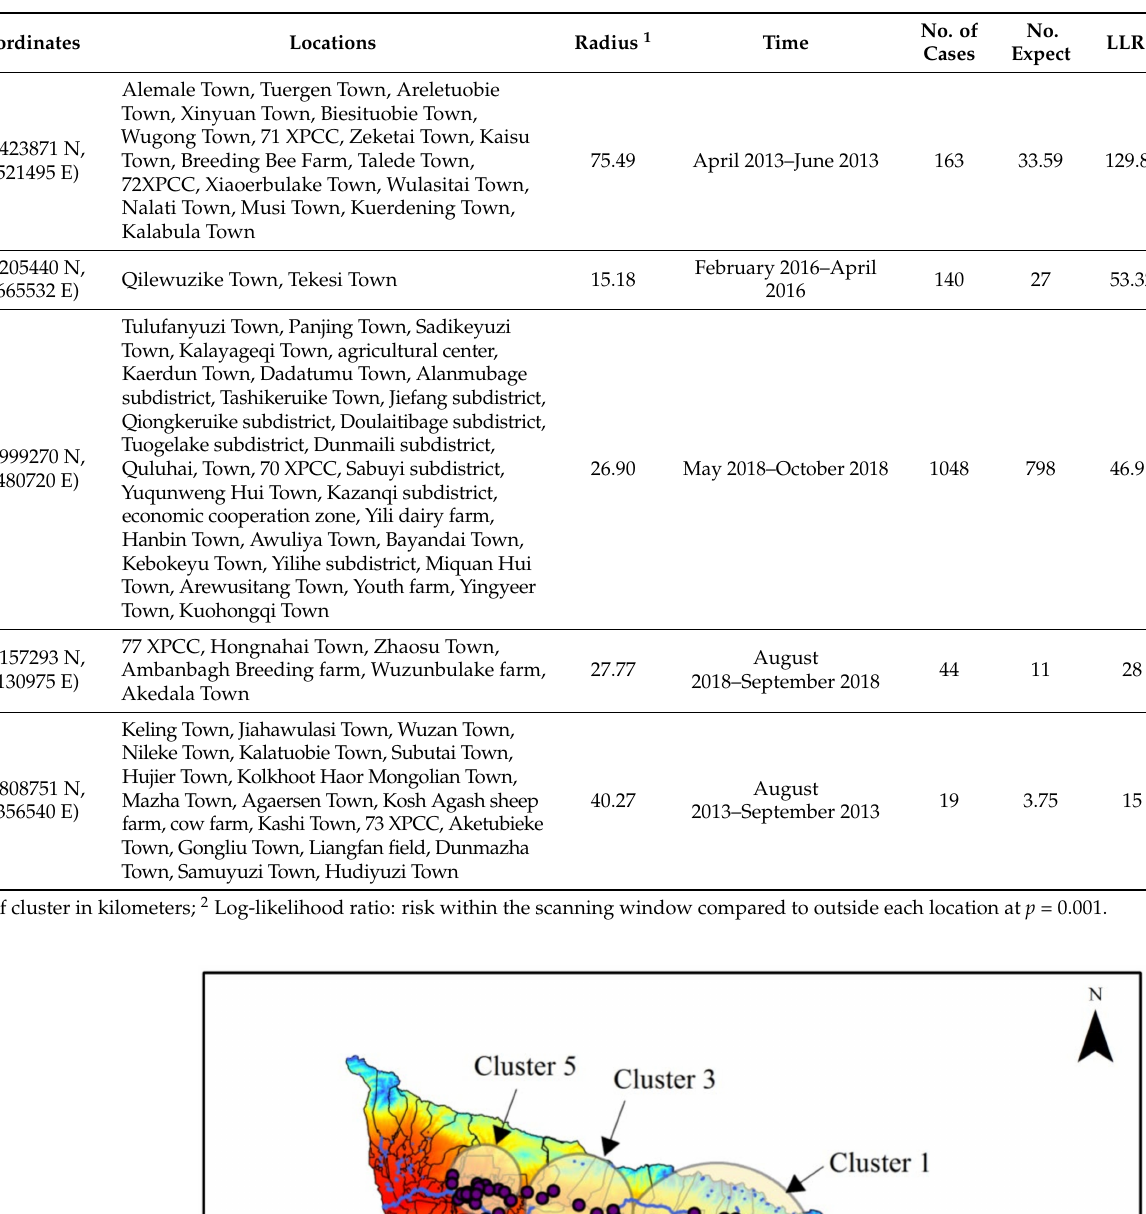
Table 1. Statistical results of the HFMD retrospective space–time scan.